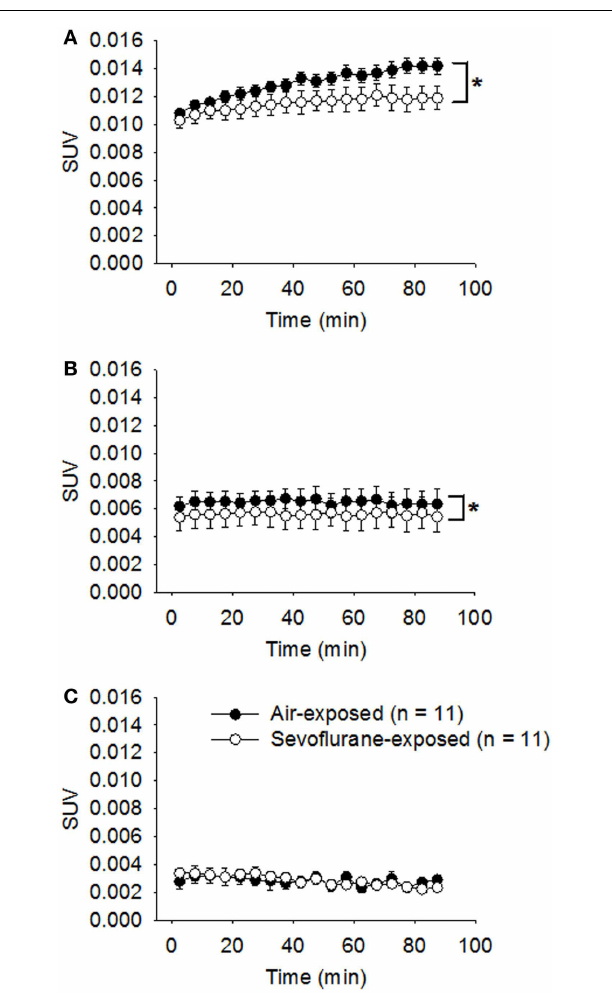
FIGURE 2 |Attenuated [ 18 F]FLT uptake in the hippocampal region was revealed by serial microPET scans for the first 2weeks following sevoflurane exposure on PND 7 . On PND 7, the treated rats were exposed to sevoflurane (2.5%) mixed with oxygen for 9h ( n = 11); the control rats ( n = 11) were exposed to room air. One (A) , 2 (B) , and 4 (C) weeks following the exposure, the animals were examined using microPET (scan time = 90min) following the administration of [ 18 F]FLT (18.5MBq/dose) by i.p. injection. Standard uptake values (SUVs) are presented as means ± SEM.The [ 18 F]FLT uptake in the hippocampus of sevoflurane-exposed rats was significantly attenuated compared with air-exposed rats in weeks 1 ( p < 0.0001) and 2 ( p = 0.0108) following the anesthetic exposure. (* p < 0.05, repeated measures linear mixed effect model). By week 4, the SUVs in the sevoflurane-exposed rats and the air-exposed rats were no longer significantly different ( p = 0.9047, repeated measures linear mixed effect model).